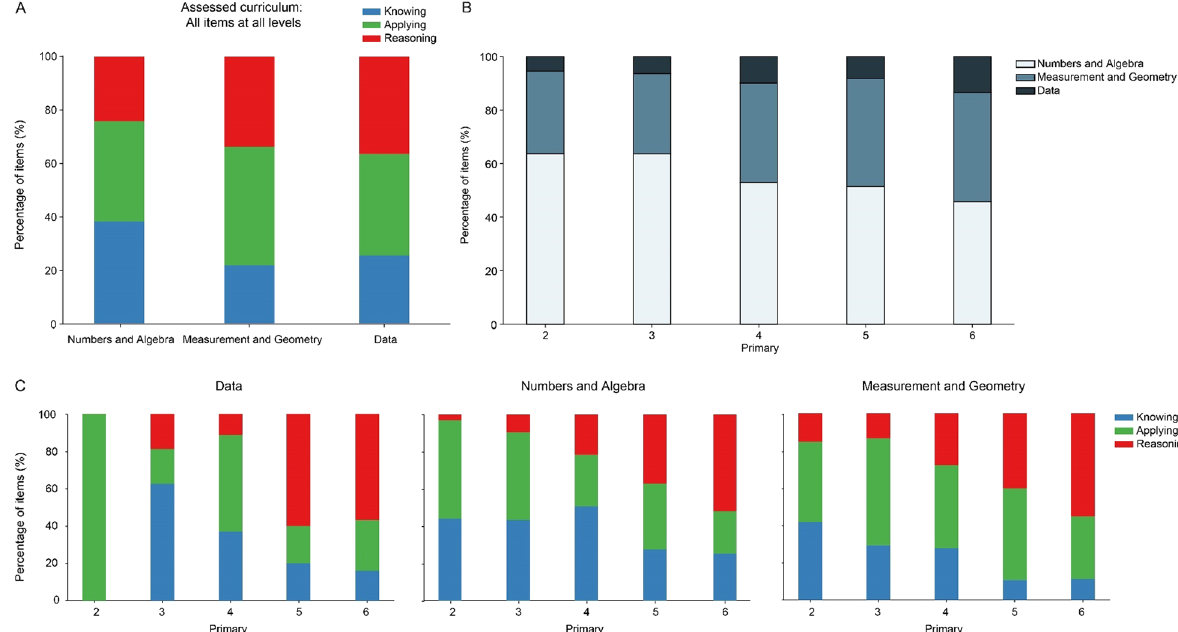
Fig. 3 Comparing mathematics content domains in the assessed curriculum in Singapore. A Cognitive domains in different content domains for assessment items combined across all primary levels. B Percentage of assessment items in different content domains from Primary 2–6. C Cognitive domains of assessment items from Primary 2–6 in different content domains from Primary